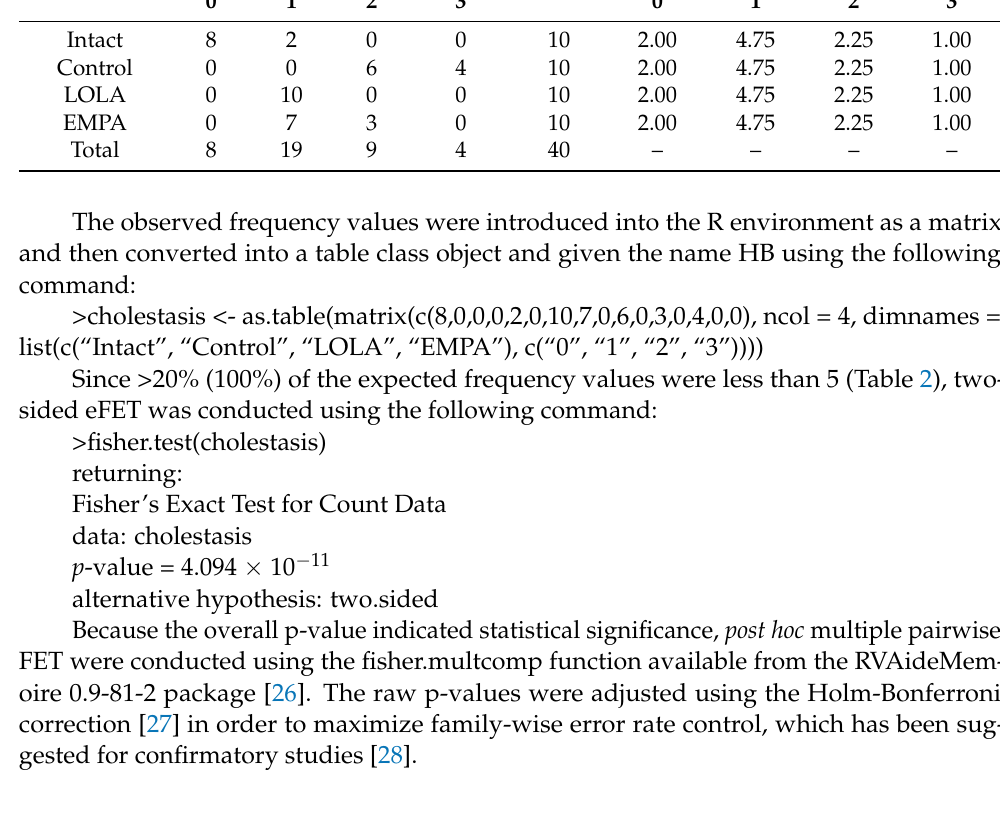
Table 2. Observed and expected cholestasis score frequency distributions for the experimental groups.